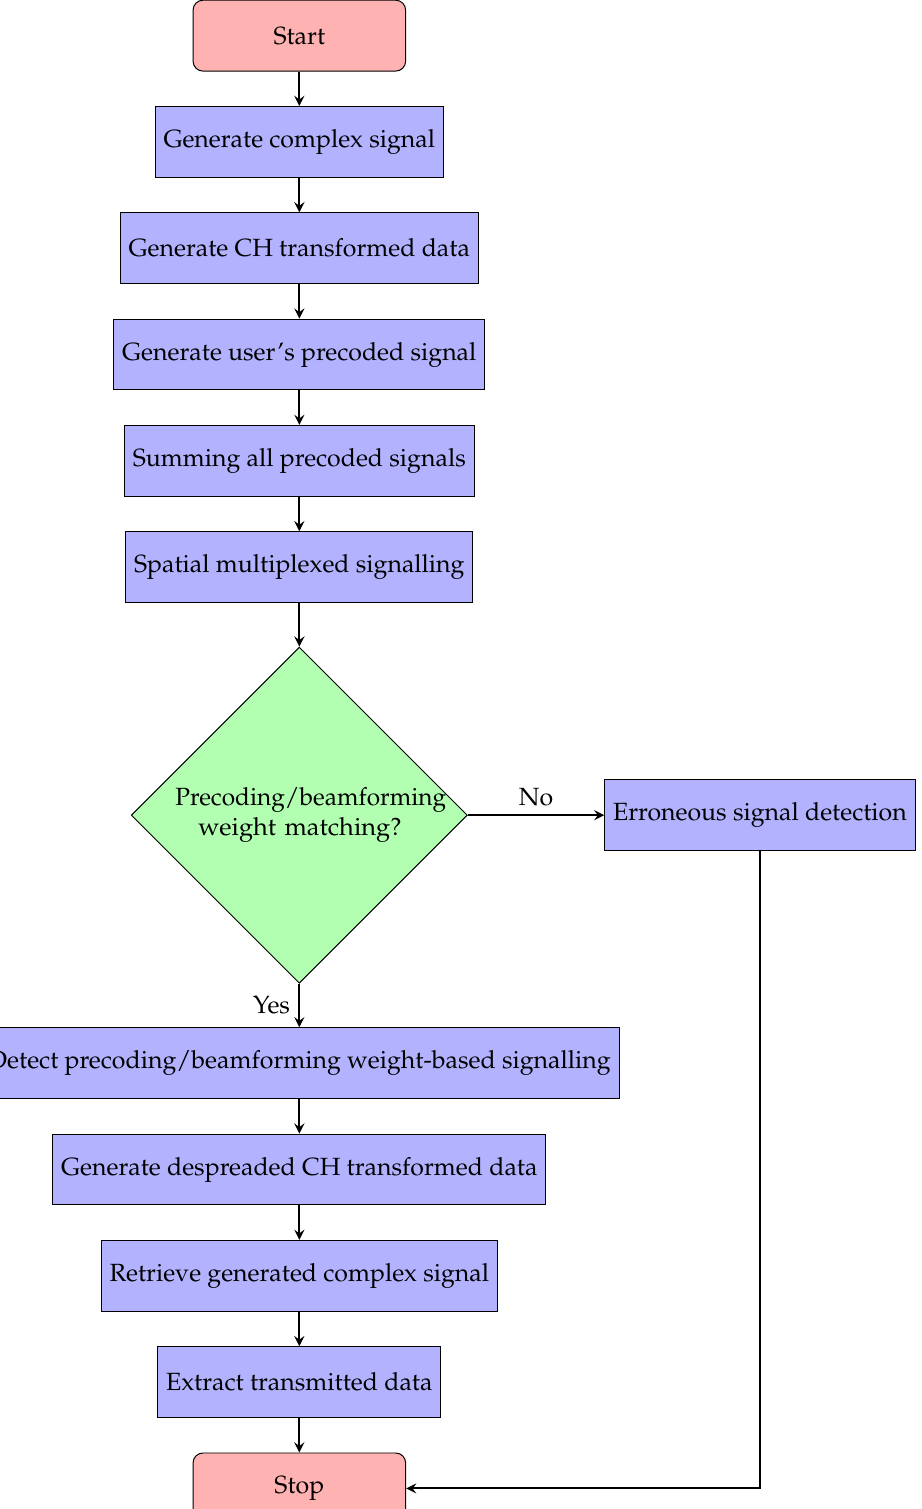
Figure 4. Flow-chart of the simulated